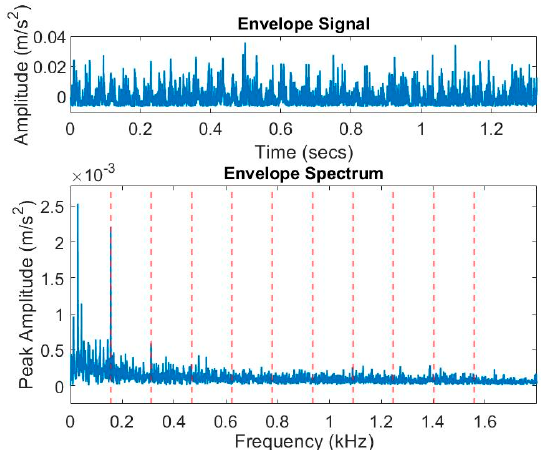
Figure 12. Envelope signal and envelope spectrum. Fan end (FE) signal with damage on DE bearing. In red, the first ten x BPFI harmonics.